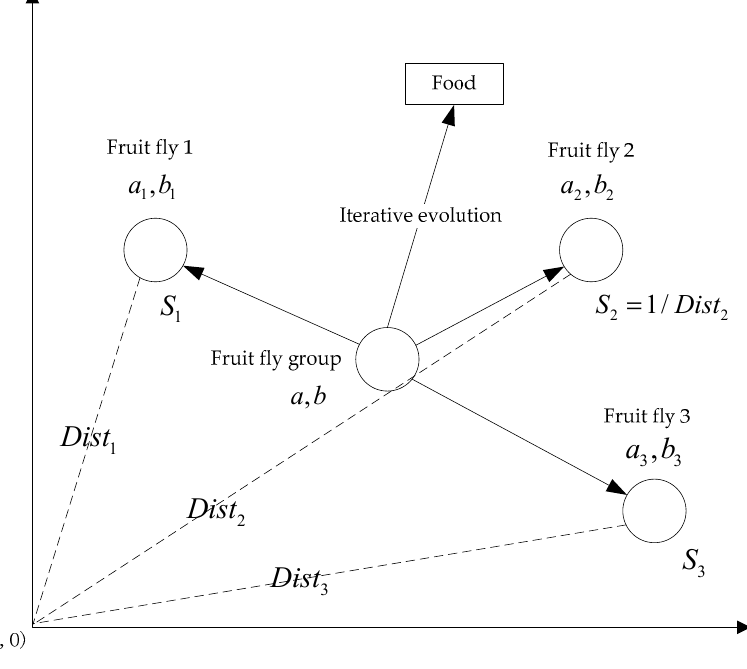
Figure 2. Fruit fly optimization algorithm.